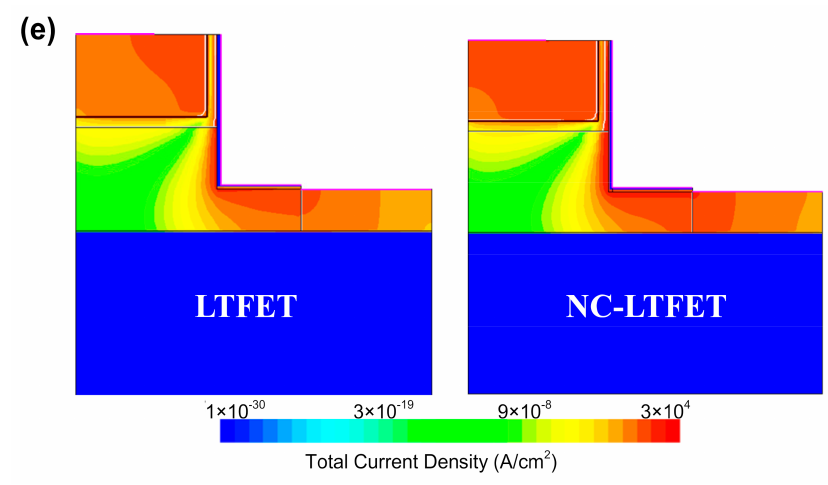
Figure 3. ( a ) The transfer characteristic curve of NC-LTFET and LTFET, ( b ) the electrostatic potential of NC-LTFET and LTFET along A-B direction, ( c ) the band energy of NC-LTFET and LTFET along A-B direction, ( d ) the band-to-band generation rate of NC-LTFET and LTFET along C-D direction, ( e ) total current density distribution of NC-LTFET and